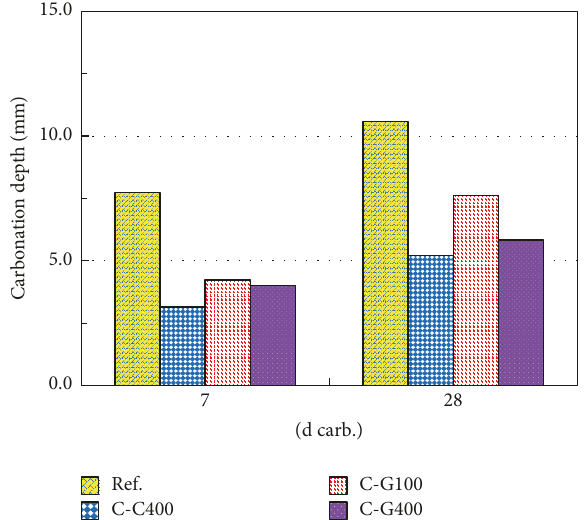
Figure 11: Carbonation depth of untreated and surface impregnated concrete after 7 and 28 days of accelerated carbonation.